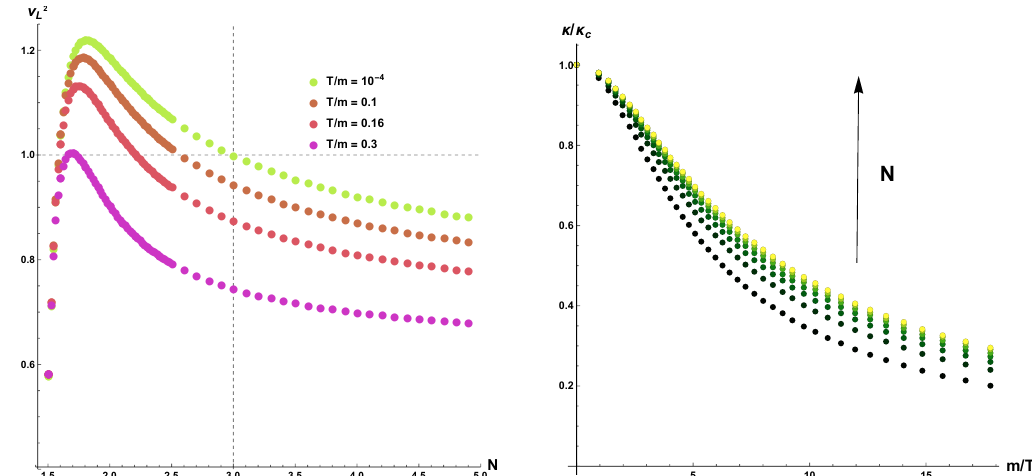
Figure 10: Left: The speed of longitudinal sound v 2 tion of N . We constrained N > 3 / 2 because below that value G < 0 and the models are dynamically unstable. Right: The stiffness κ ≡ ∂ p /∂ ε for various N ∈ [ 3,9 ] (from black to yellow) in function of m / T